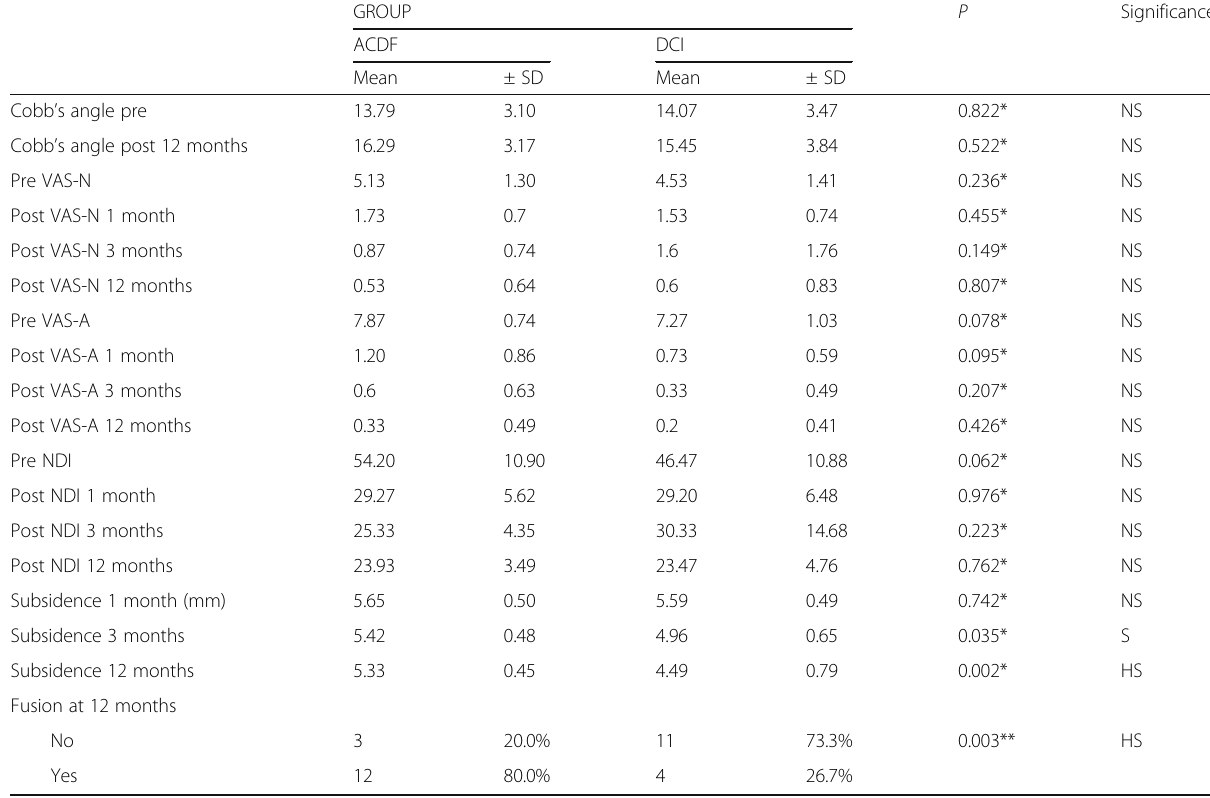
Table 8 Comparison between the two study groups as regard clinical and radiological findings preoperatively and postoperatively GROUP P